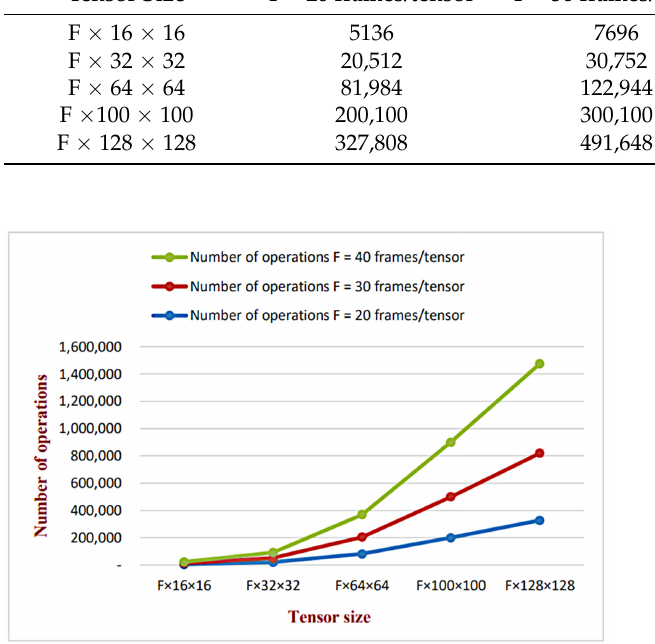
Figure 6. The increase in total number of operations against the increase in tensor size.